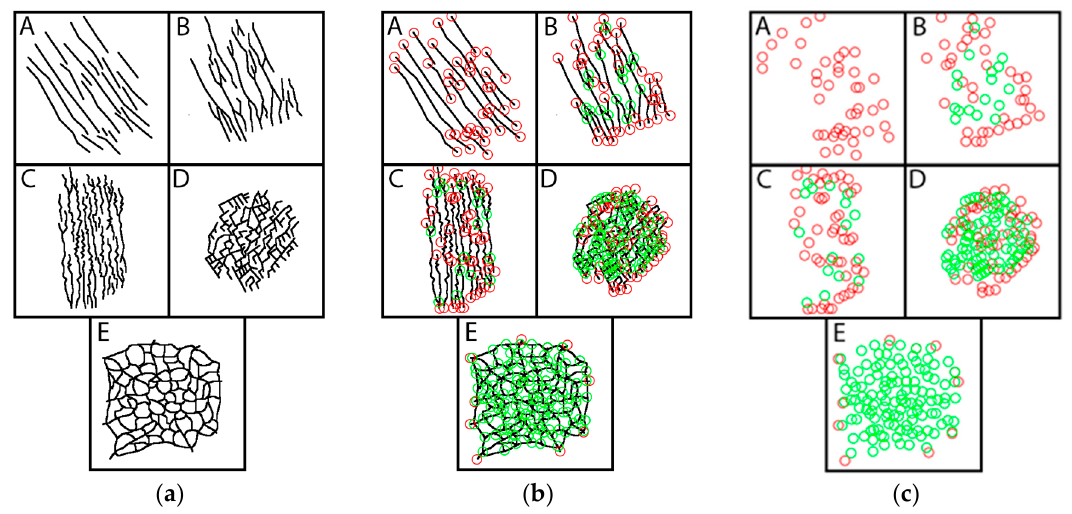
Figure 18. TAR representational schemes. ( a ) (Traced) Generalized TAR crests following the categorization scheme of [101]. (A) Simple, (B) forked, (C) sinuous, (D) barchan-like, and (E) networked. ( b ) (Annotated) Generalized TAR crests with annotated defects. Terminations (red circles) and bifurcations (green circles) are marked. More than 400 defects were located in these five small examples. ( c ) (Defects) Extracted defects from each TAR morphology. Even without direction information, each morphology’s defects are distinctly di ff erent, with the exception of forked vs. sinuous.